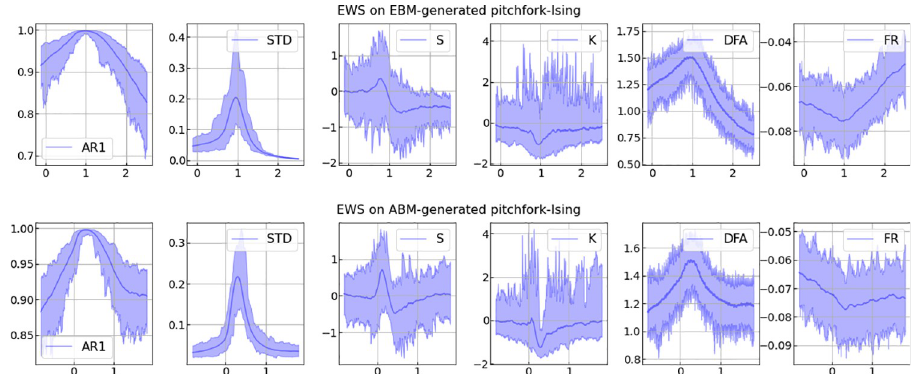
Fig 8. EWS analyses of the pitchfork transition. Results of selected EWS-analyses applied to time series of length 500 generated with rolling windows over the parameter spaces of the pitchfork transition. Data generated with the EBM- and ABM-models as described in the section: Ising model. Considered EWS-indicators are auto-correlation with lag-1 (AR1), standard deviation (STD), skewness (S), kurtosis (K), detrended fluctuation analysis (DFA) and spectral reddening